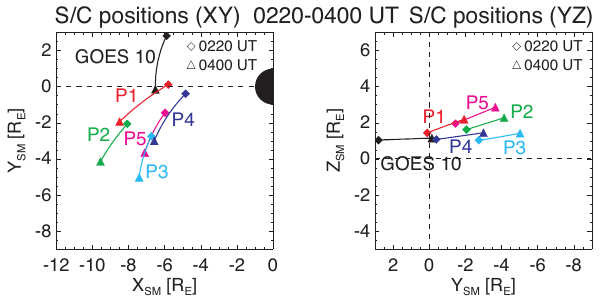
Fig. 1. Positions of THEMIS P1 to P5 and GOES 10 between 02:20UT and 04:00UT on 12 December 2007 in the XY (left) and YZ (right) planes in SM